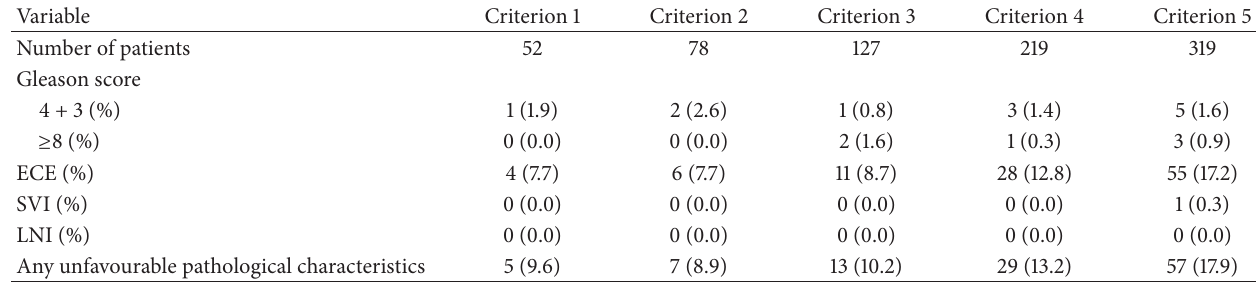
Table 3: Unfavourable pathological characteristics per biopsy